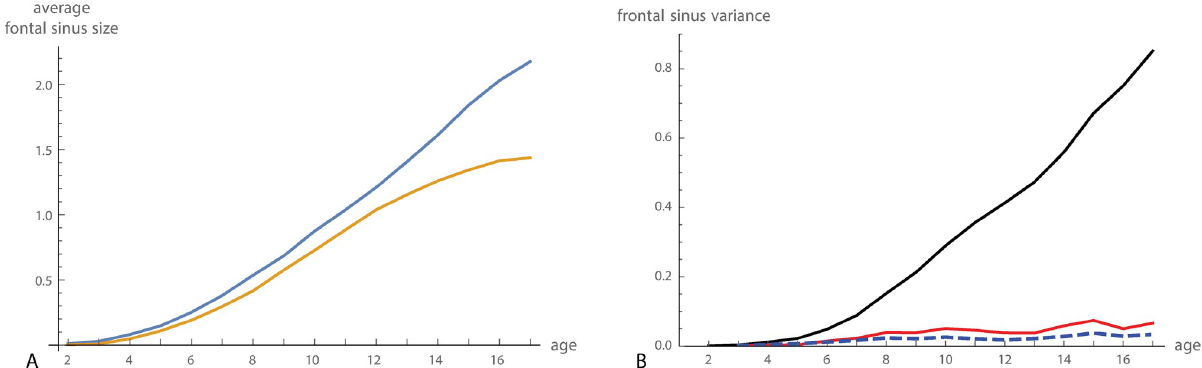
Fig 6. Frontal sinus size. (A) Average frontal sinus size for boys (blue) and girls (orange) in the Denver growth sample. (B) Cross-sectional variance (black curve), canalized variance (red curve), and newly added variance (blue dashed curve) for frontal sinus size.